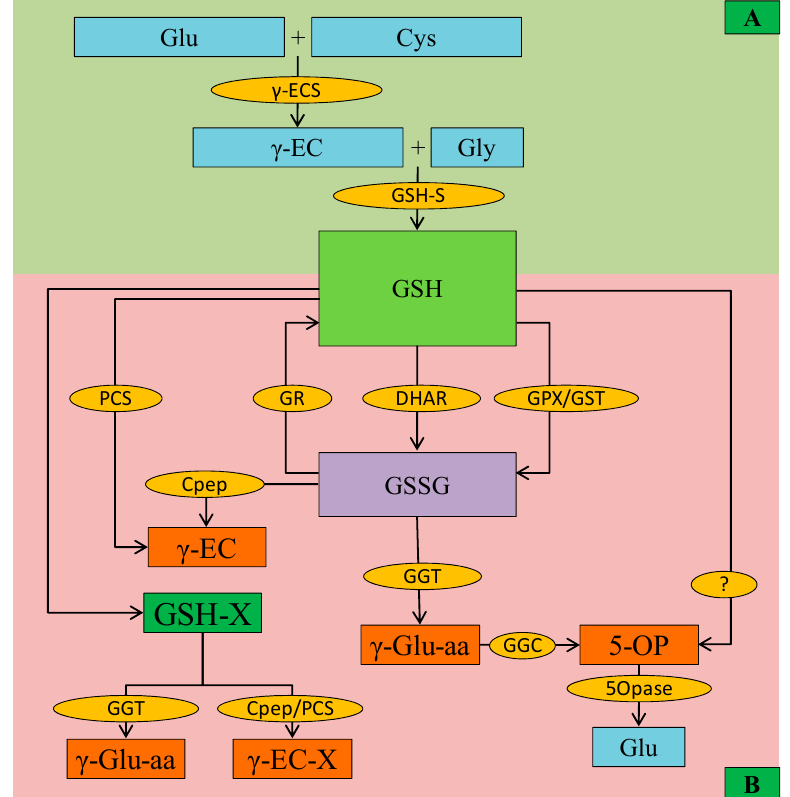
Figure 3. Glutathione biosynthesis, metabolism, and degradation in plants. ( A ) Biosynthesis the first step occurred in plastid: Glu and Cys form γ -glutamylcysteine ( γ -EC) catalyzed by γ -EC synthetase ( γ -ECS). The second step occurred in the cytosol or in plastid: γ -EC and Gly bond together to form GSH catalyzed by GSH-S (glutathione synthase). Further, GSH participates in ROS scavenging and is converted into GSH/glutathione disulfide (GSSG) by the enzyme glutathione peroxidase (GPX), glutathione S -transferase (GST), and DHAR. Further GSSG can be recycled to GSH by the